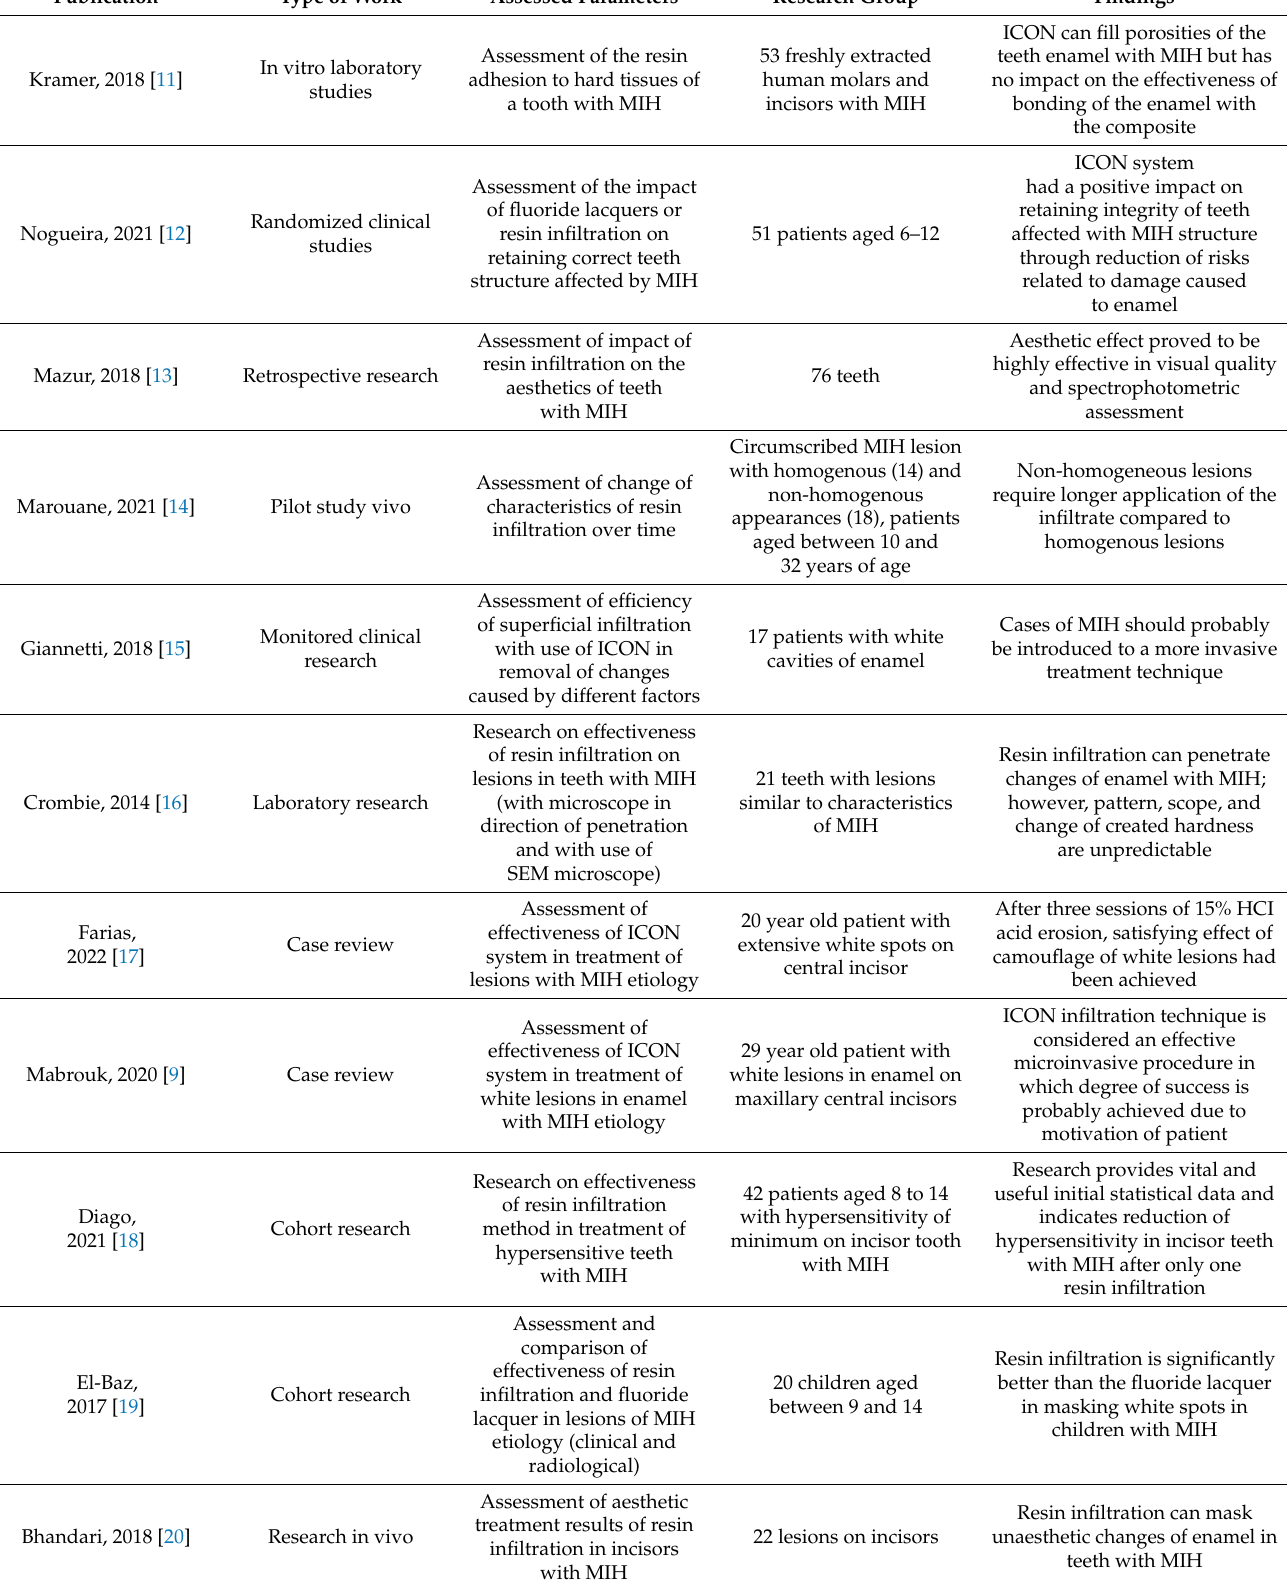
Table 1. The analysis of publications included in the